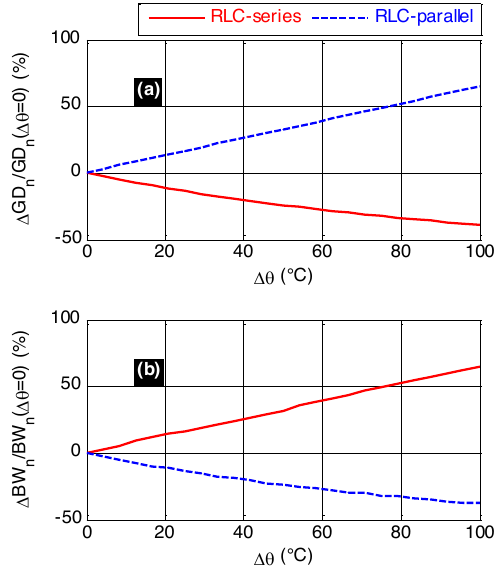
FIGURE 7. Variation of (a) NGD value and (b) NGD BW of circuits shown in Figs. 5 versus temperature variation.